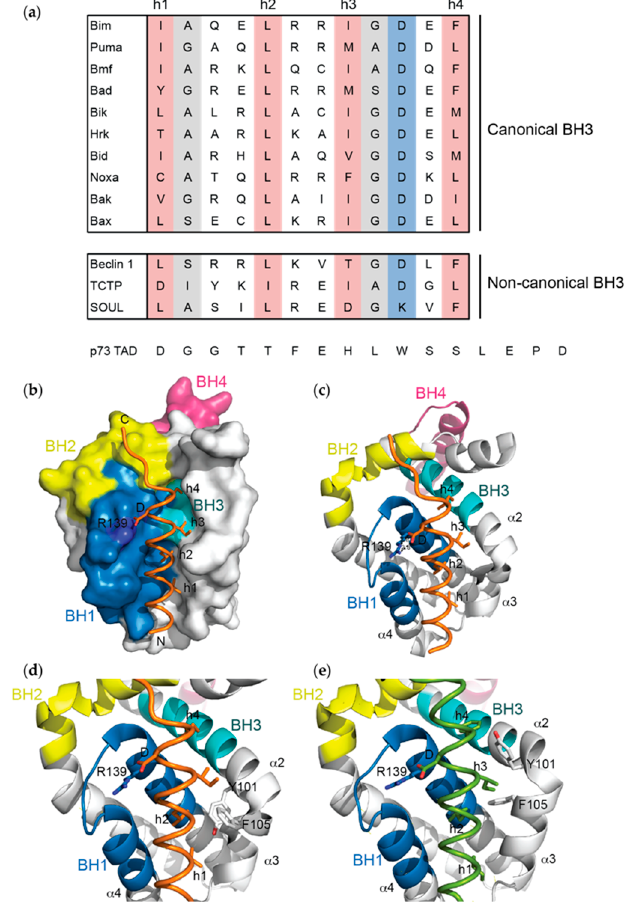
Figure 2. ( a ) Sequence alignment of BH3 domains. Canonical BH3 domains that bind with high a ffi nity to pro-survival proteins are defined by the presence of four conserved hydrophobic residues (h1 to h4, pink), an invariable aspartic acid (blue) and amino acid residues with smaller side-chains in positions highlighted in grey. In contrast, the a ffi nities of non-canonical BH3 domains are weaker due to non-conserved amino acid substitutions at these key positions. The p73 TAD sequence that binds Bcl-x L with weak a ffi nity has no sequence homology to BH3 domains; ( b , c ) The structure of the Bak BH3 domain (orange) in complex with Bcl-x L defined the conserved mechanism by which pro-apoptotic proteins bind their pro-survival targets (PDB ID: 5FMK)—the four conserved hydrophobic residues (h1–h4) project into pockets along the hydrophobic groove, the invariant aspartic acid forms an electrostatic interaction with a conserved arginine in the BH1 domain of Bcl-x L , and the BH3 domain forms an amphipathic helix that binds into the groove; ( d , e ) The orientation of Tyr-101 and Phe-105 of Bcl-x L changes relative to the hydrophobic groove depending on the BH3 domain that engages it (e.g., ( d ) Bak BH3 (orange):Bcl-x L , PDB ID: 5FMK; ( e ) Bim BH3 (green):Bcl-x L , PDB ID: 3FDL). Notably, these residues lie in the α 2- α 3 corner of Bcl-x L that is associated with significant